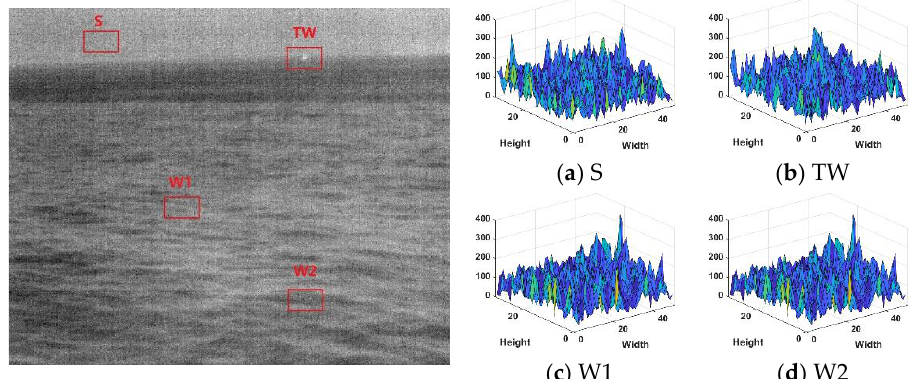
Figure 2. Rough sea image and 3D figure of local gradient amplitude. ( a ) Sky area; ( b ) dim point target area; ( c ) sea clutter area W1; ( d ) sea clutter area W2.